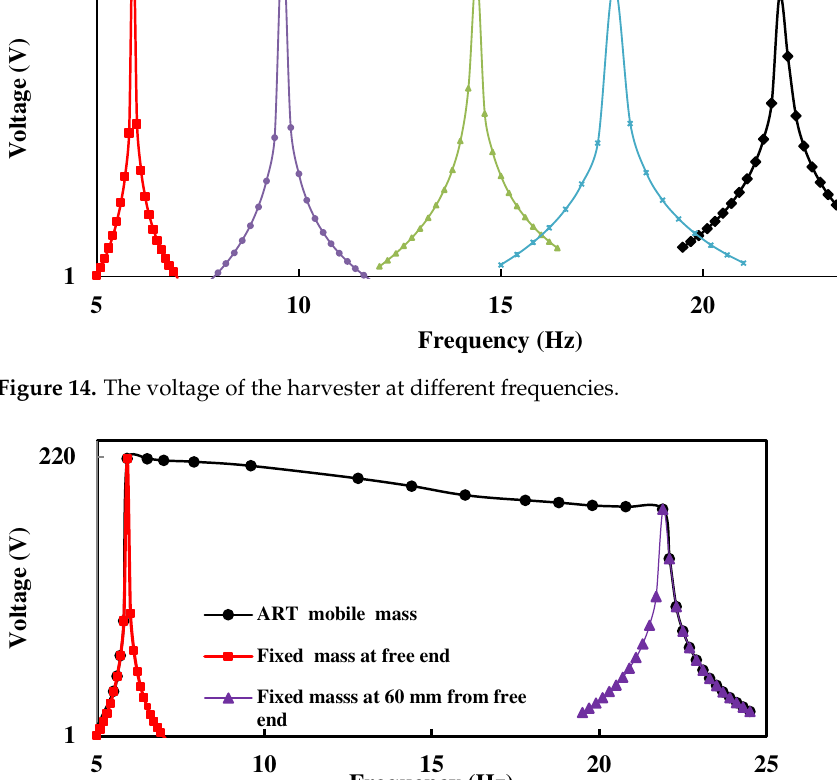
Figure 16. The frequency response of the output power of the piezoelectric harvester at two posi- tions for the mobile mass.